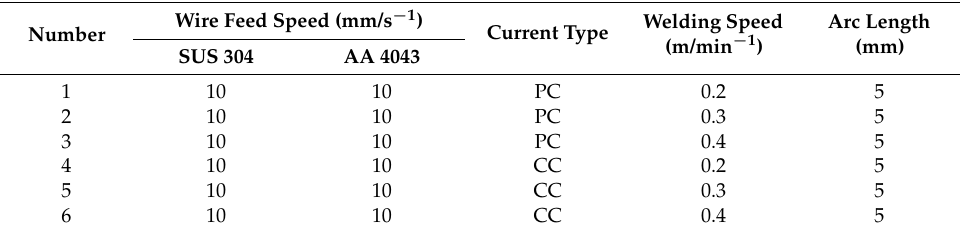
Table 2. Experimental parameters.